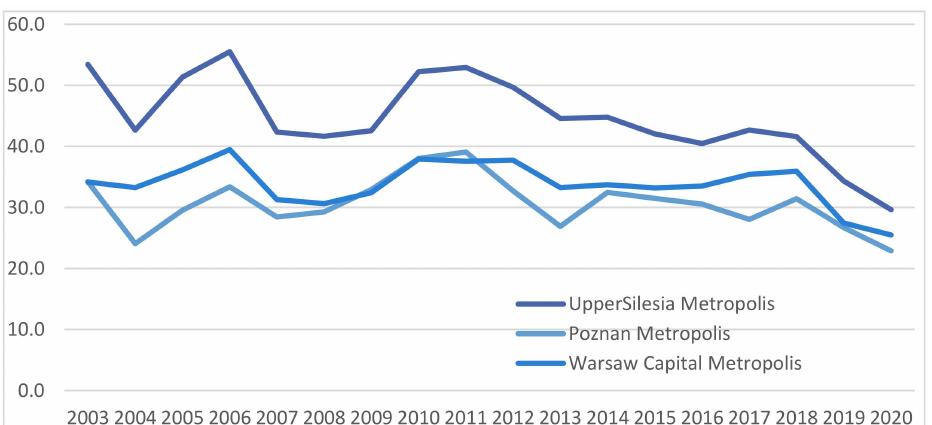
Figure 8. The results of PM 10 measurements in three metropolises in Poland in the period from 2003 to 2020. Source: Own elaboration based on measurements